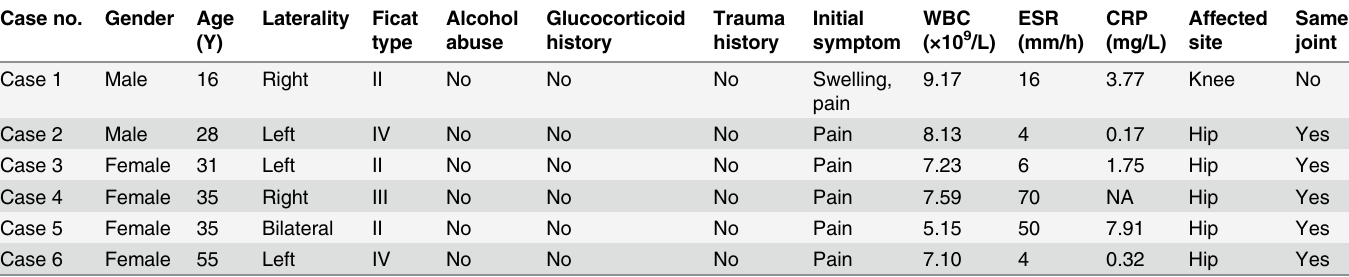
WBC = white blood cell count, ESR = erythrocyte sedimentation rate, CRP = C-reactive protein. NA = not available, Y =